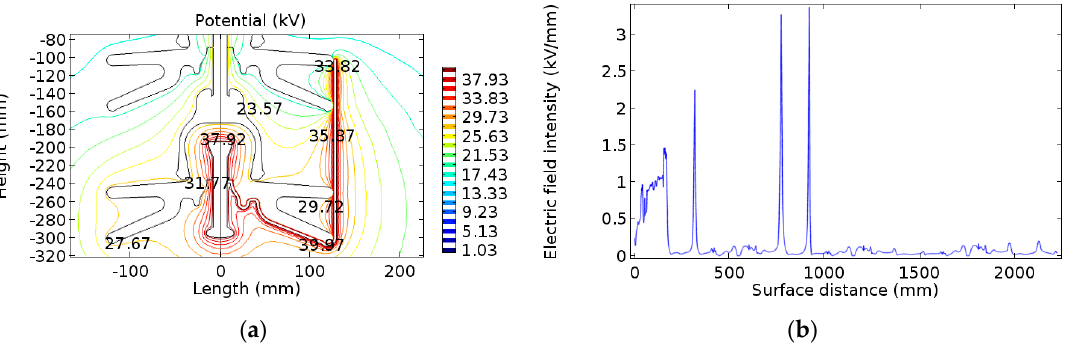
Figure 23. Simulation results of Bridge 3: ( a ) equipotential line distribution; ( b ) electric field distribution along insulator string.